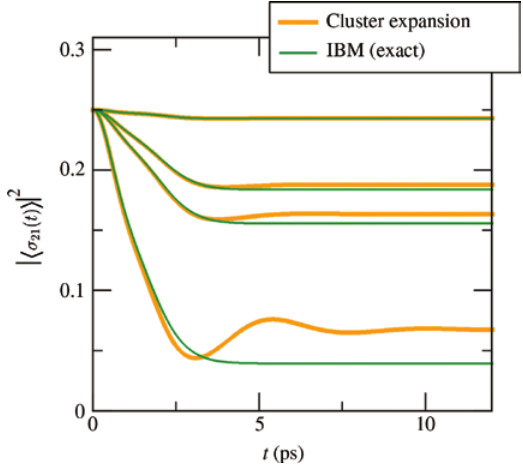
Figure 3: Comparison for different temperatures (from top to bottom 4, 50, 77, 100 K) between the independent boson solution from Eq. (25) (green) and the second-order cluster expansion solution from Eq. (32) with Ω ( t ) = δ ( t )/2 (orange). For low temperatures and typical semiconductor parameter as given in the text, the solutions agree well up to around 60